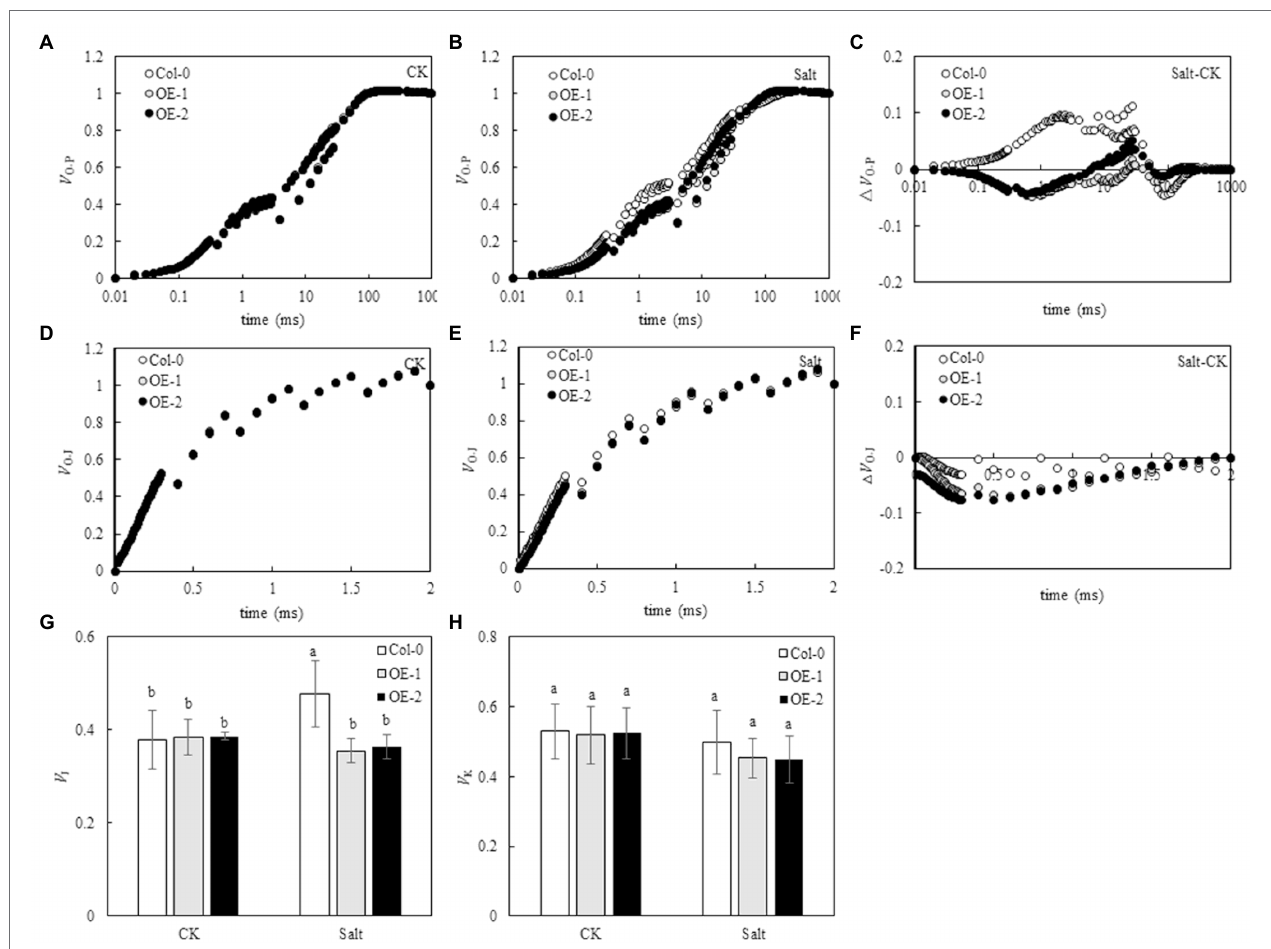
FIGURE 5 | Effects of MYB37 overexpression on standardized O-P curve (A, B) , △ V O-P curve (C) , standardized O-J curve (D, E) , △ V O-J curve (F) , V J (G) , and V K (H) in Arabidopsis leaves under NaCl stress. Data are expressed as means ± SE of three replicated experiments ( n = 3). Different small letters indicate significant differences ( p <